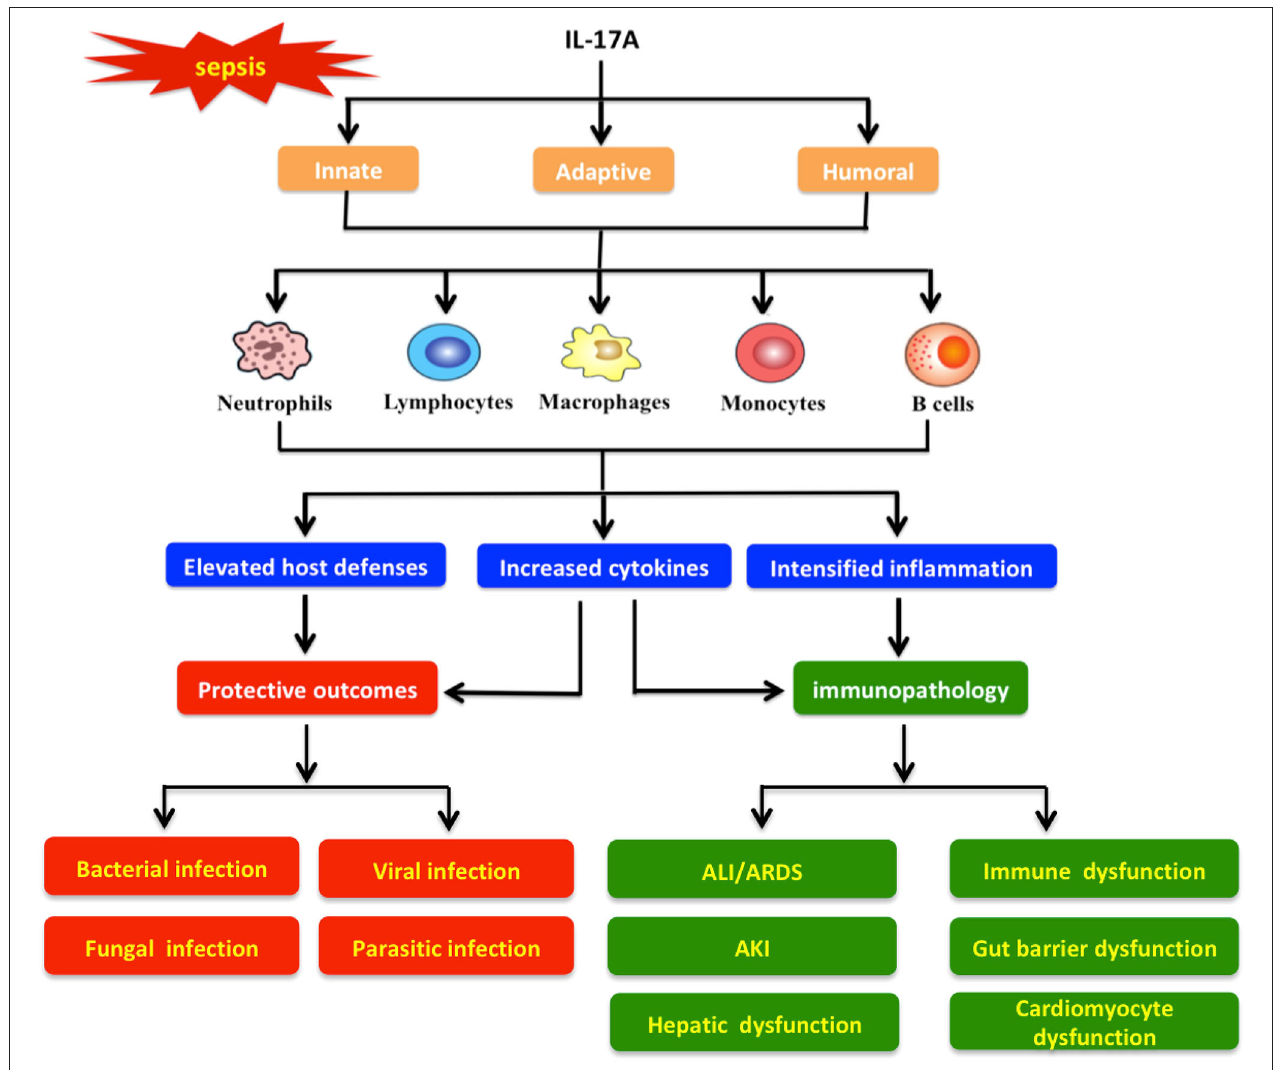
FIGURE 5 | Protective and pathological roles of interleukin-17A in the pathogenesis of sepsis. IL-17A triggers various immune cells (e.g., neutrophils, lymphocytes, macrophages, monocytes, and B cells) to boost innate, adaptive, and humoral responses with different actions. Meanwhile, IL-17A signaling exhibits a strong protective effect against diverse infections (e.g., bacterial, fungal, viral, and parasitic infections) through promotion of host defenses and cytokine release. In addition, IL-17A may induce pathologic immune responses and then impair organ functions, which result in pathological alterations such as acute lung injury (ALI)/acute respiratory distress syndrome (ARDS), acute kidney injury (AKI), hepatic dysfunction, immune dysfunction, gut barrier dysfunction, and cardiomyocyte